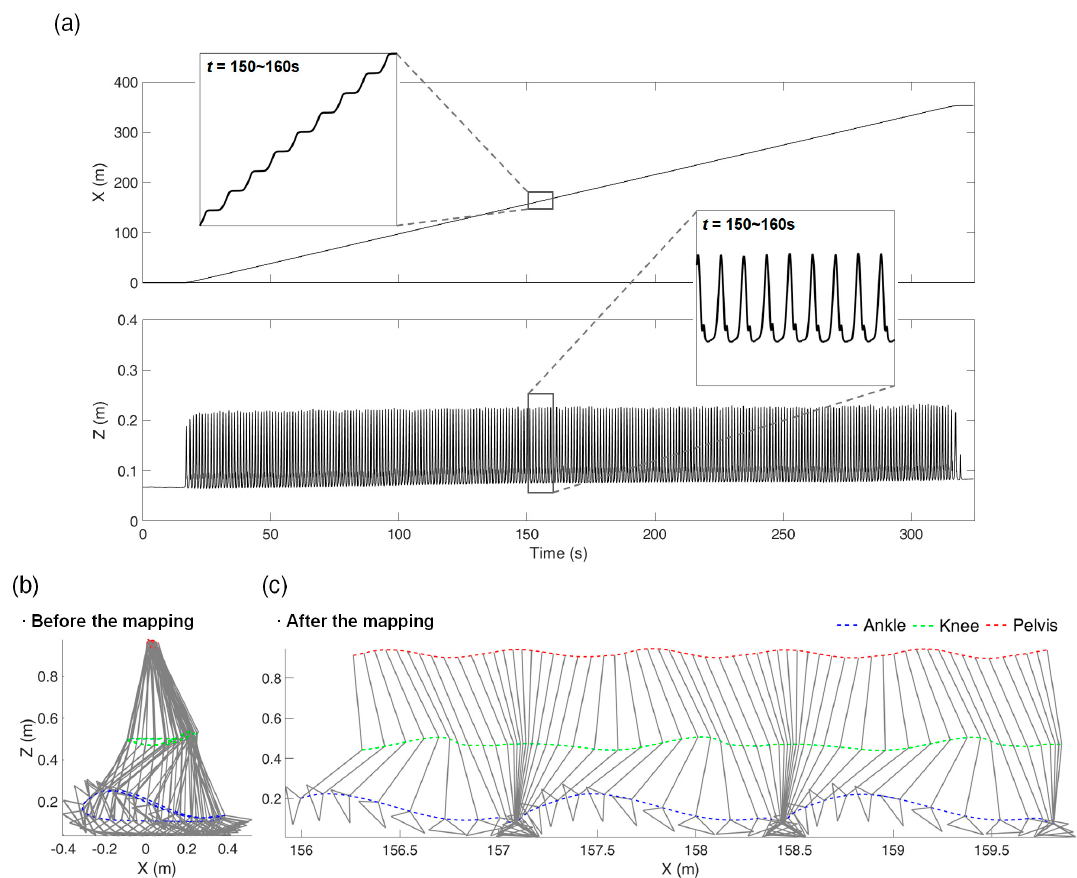
Figure 5. Mapping results from Trial 3 of the constant-speed test without inclination: ( a ) shows the x - and z -axes ankle marker trajectories with respect to time, ( b ) and ( c ) show marker trajectories on the sagittal plane before and after the mapping, respectively ( t = 150–153 s).